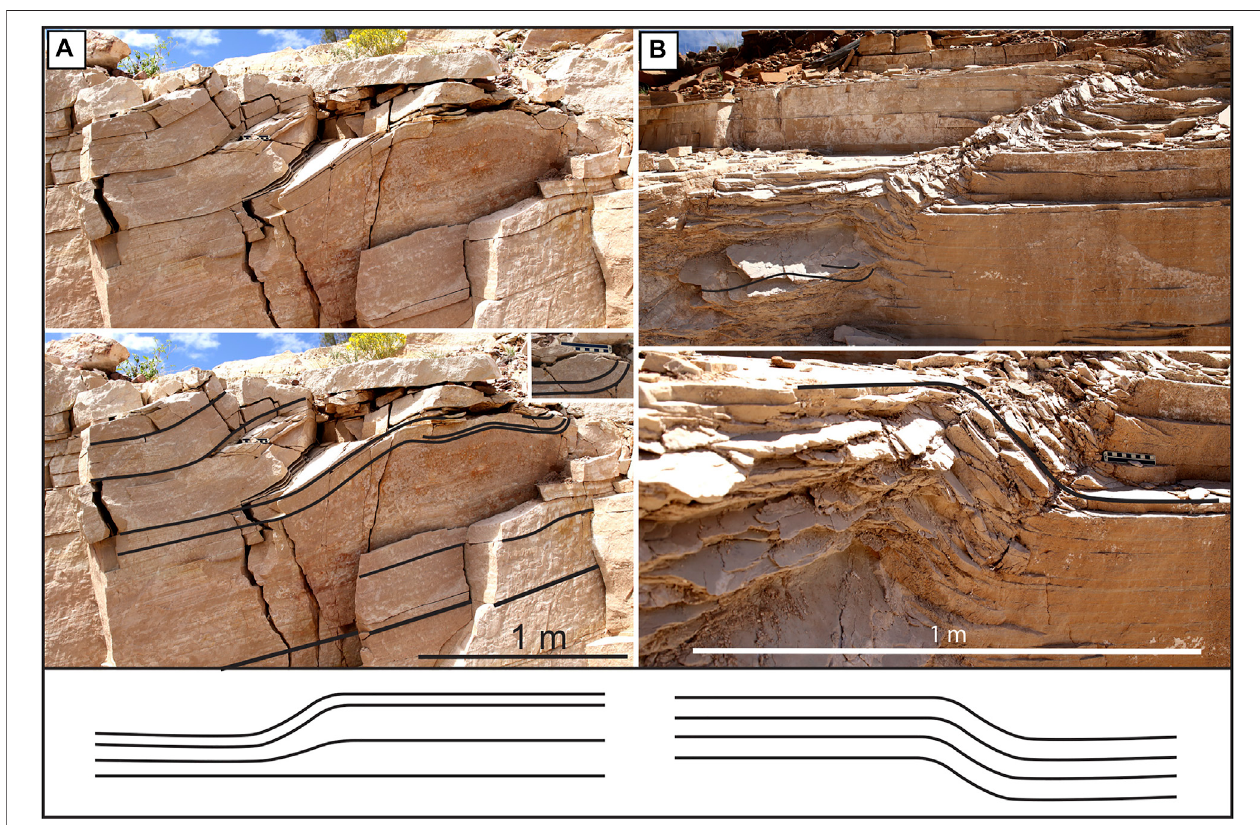
FIGURE 10 | Examples of monoclinal folds in an Ash Fork quarry. (A) Deformed bedding 1 m below the contact between the Coconino Sandstone and the overlying Toroweap Formation. (B) Deformation 44 m below the Toroweap, in the same large quarry, which had multiple exposed cross-bed sets and bounding surfaces. Lower illustrations are diagrammatic cross-sections of the